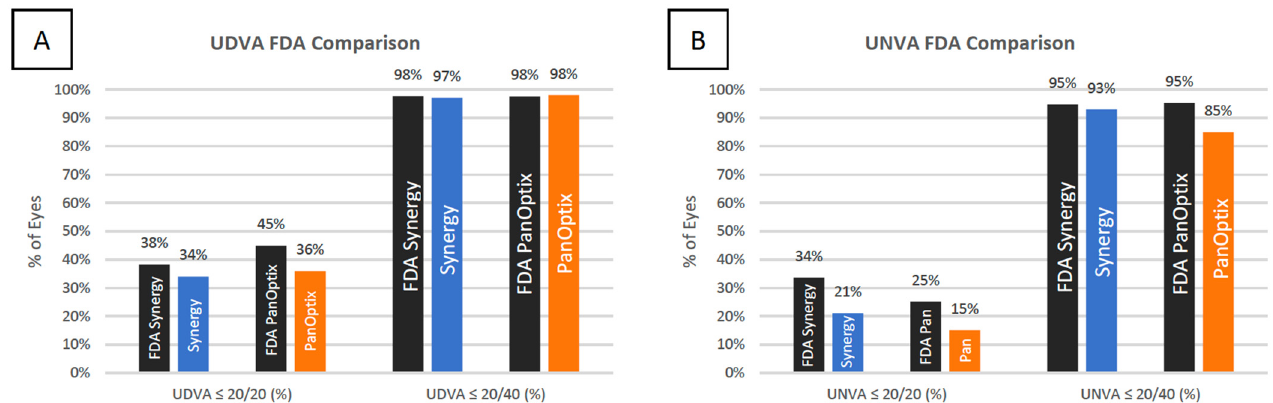
Figure 4. Comparison of the distribution of FDA values with the current study values for monocular UDVA ( A ) and UNVA ( B ) for the TECNIS Synergy and AcrySof IQ PanOptix IOLs.